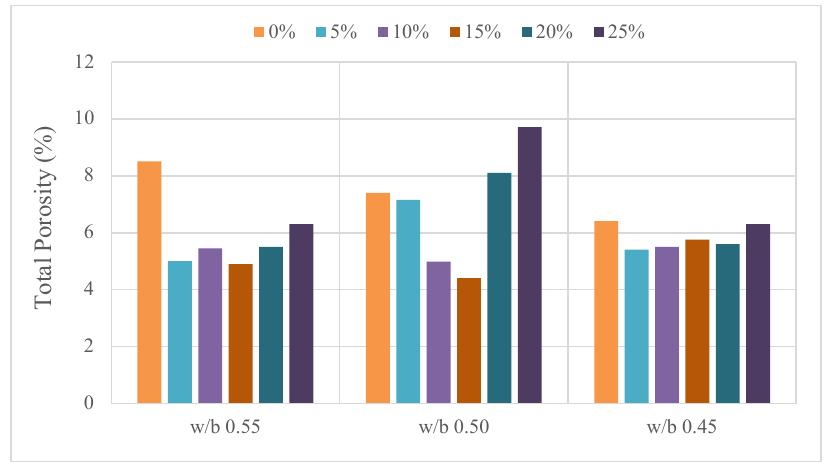
Figure 8. Porosity and wollastonite replacement based on Ref. [32].